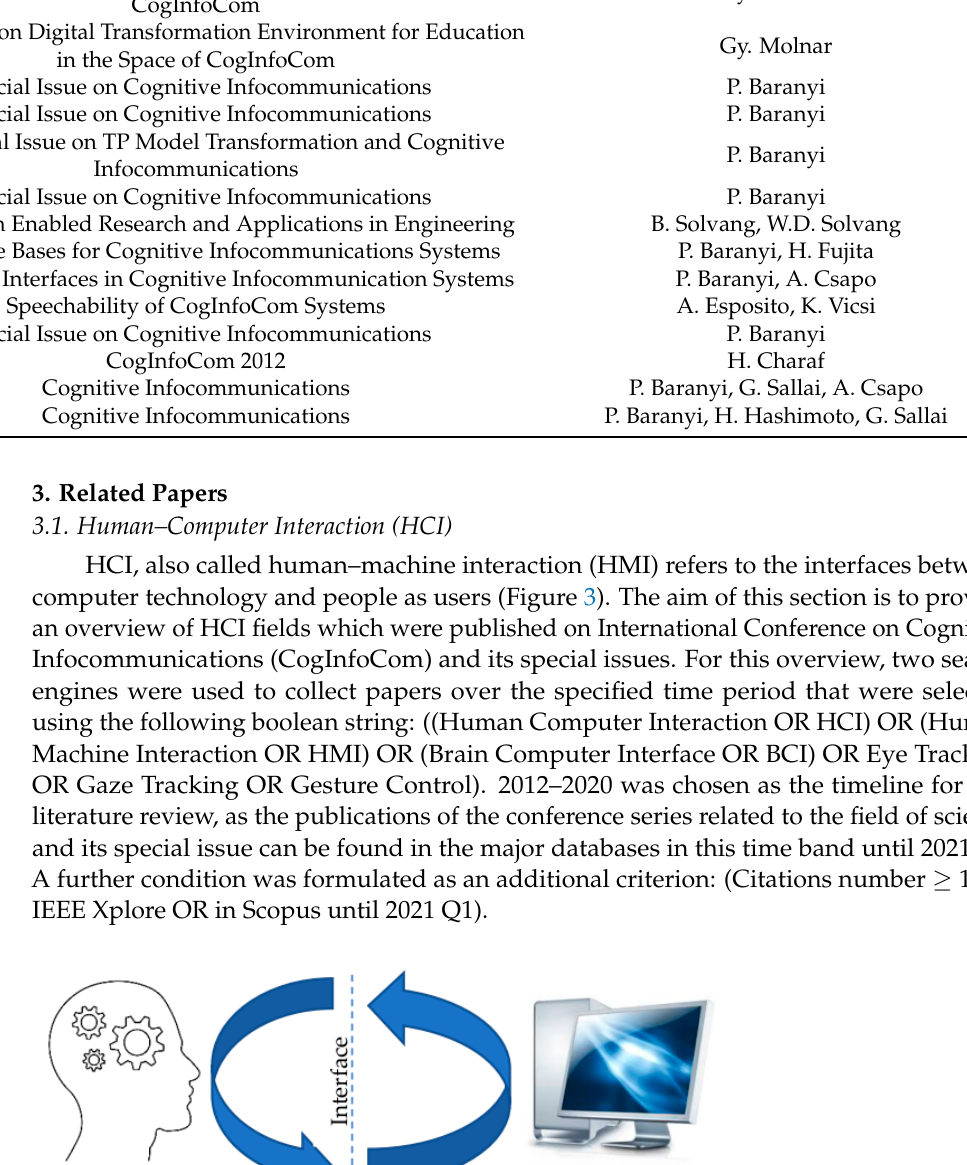
Table 1. Journal special issues related to CogInfoCom topics.